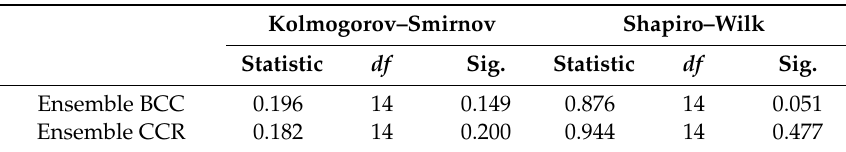
Table 4. The results of normality tests.